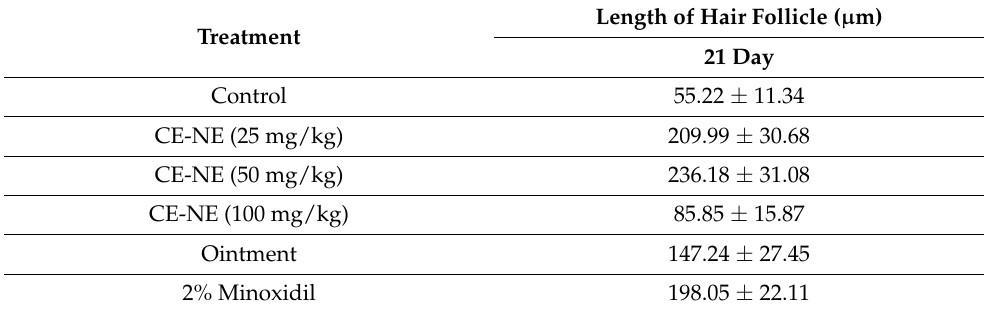
Table 6. Effect of cedrol on length of hair follicle.